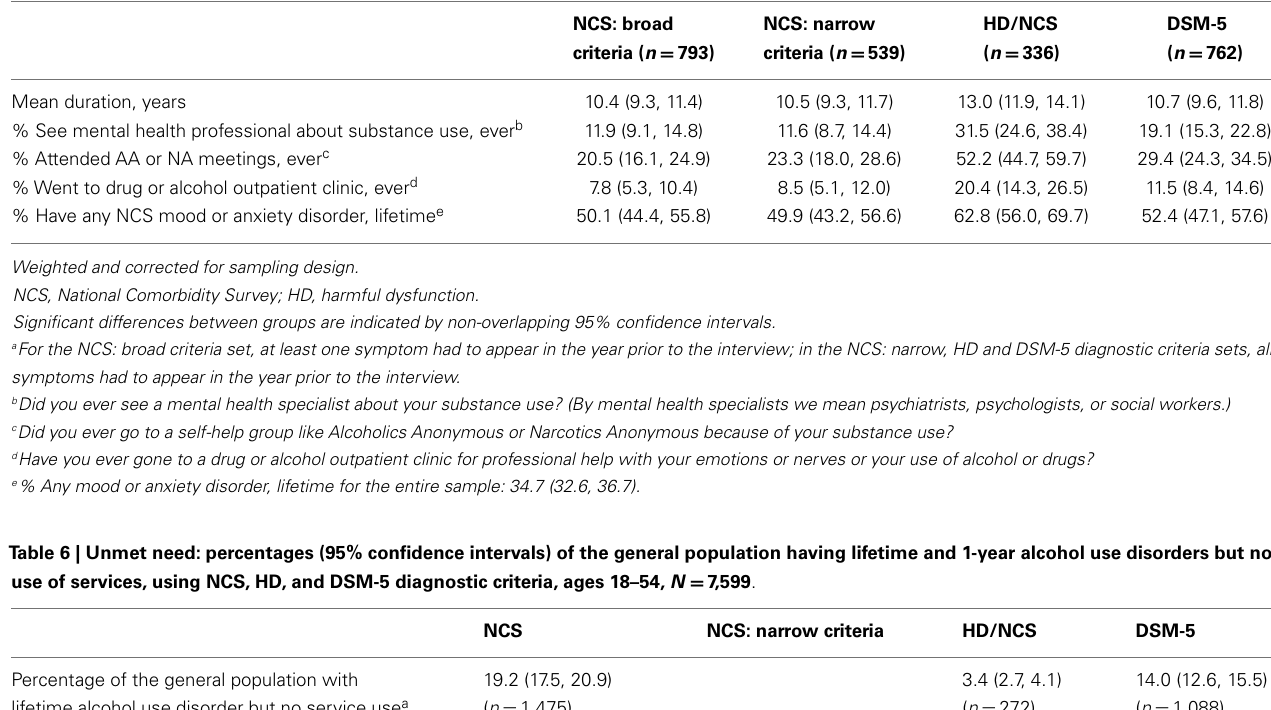
Table 5 | Means and percentages (95% confidence intervals) for validators of NCS 1-year a alcohol use disorders, ages 18–54, N = 7,599 .